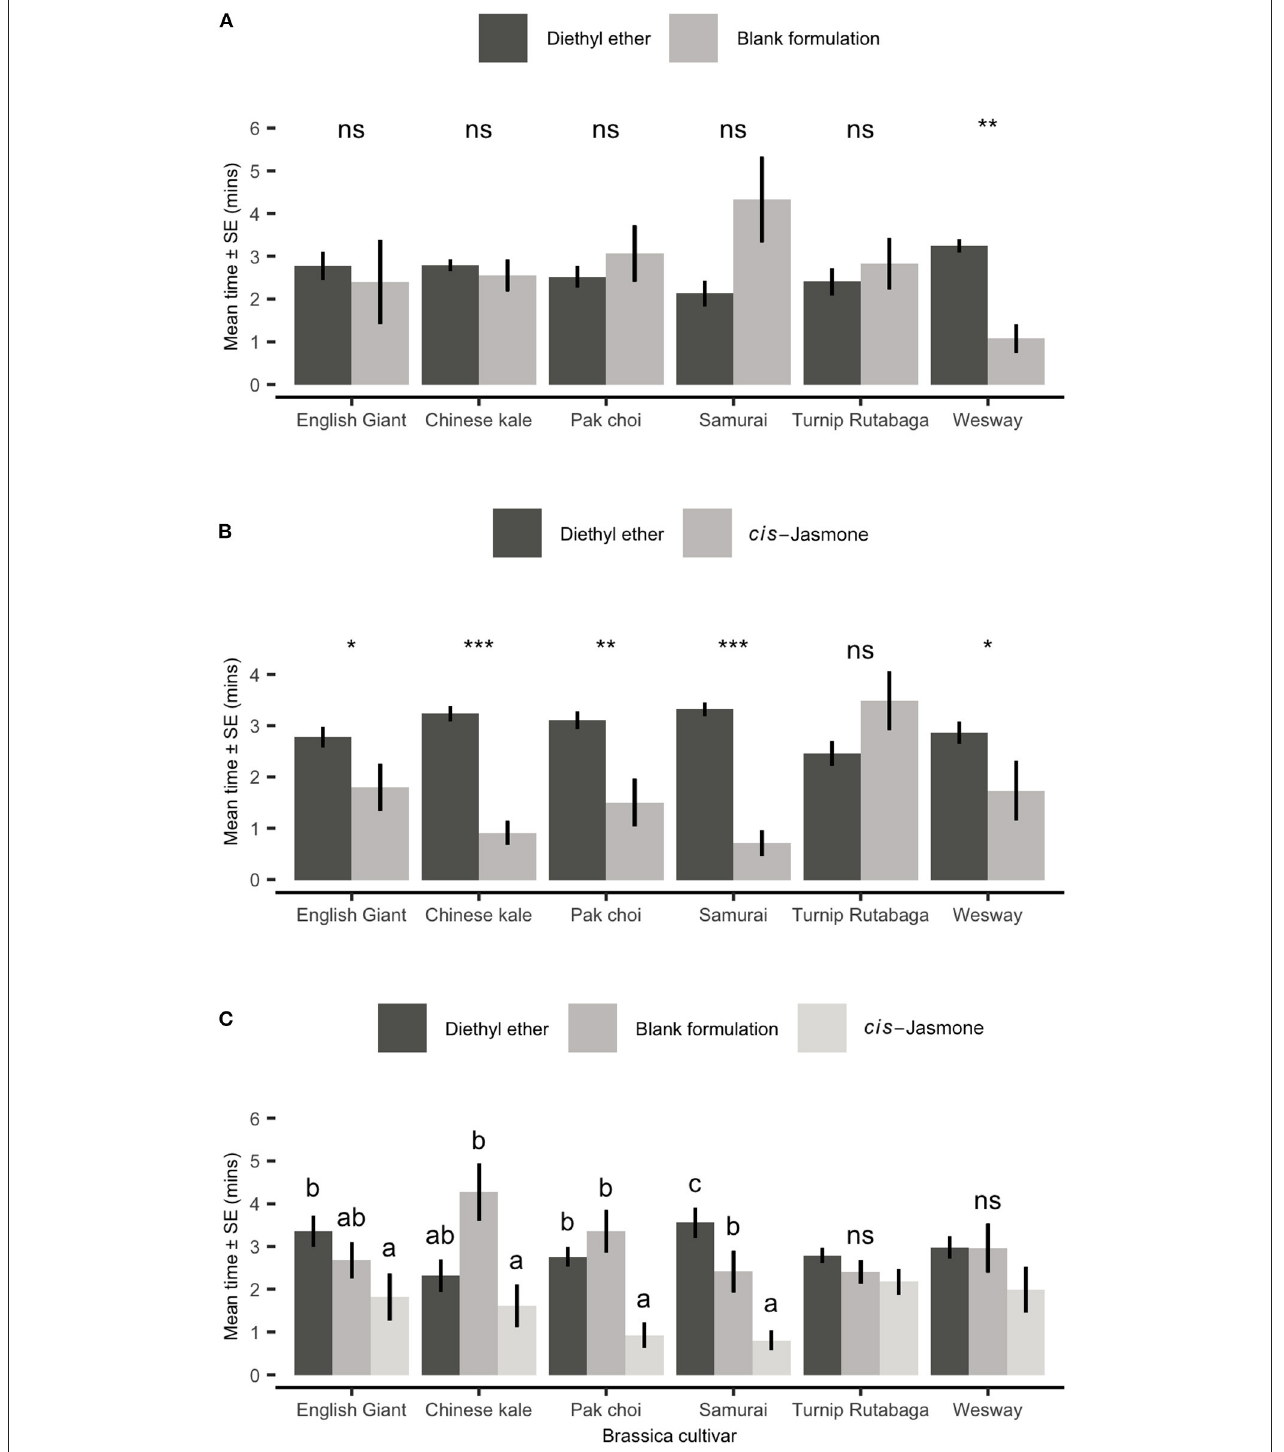
FIGURE 6 | Behavioural responses of Myzus persicae females to volatiles from six brassica cultivars in an olfactometer bioassay. Individual aphids were given 12min to make a choice between (A) one arm of blank formulation treated plants (BF—tween 80 and water) vs. three solvent diethyl ether (DEE) arms, (B) one arm of cis- jasmone treated plants (CJ) vs. three solvent control arms (DEE) and (C) two different treatment arms (BF, blank formulation treated plants and CJ, cis- jasmone treated plants) vs. two solvent arms (DEE). The shown values are mean time spent in arm ± SE ( n = 10). For (A,B) , brassica cultivars capped with “ns” do not show a significant difference between plant treatment while asterisks denote differing levels of statistical significance: * < 0.05, ** < 0.01 and *** < 0.001 (paired t- test). For (C) , different letters above bars indicate statistically significant differences between treatments ( P < 0.05), based on Holm-Sidak method.